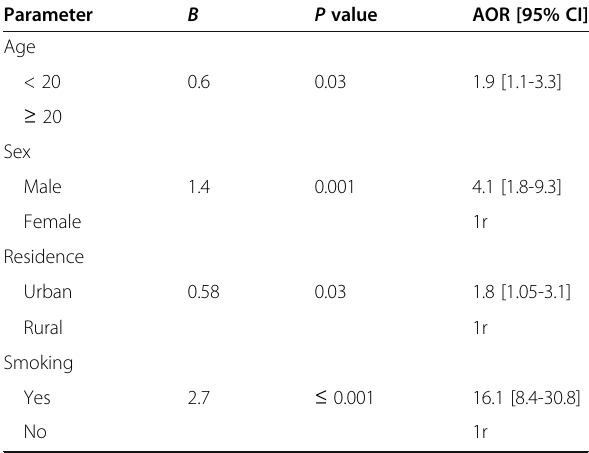
Table 5 Logistic regression of factors associated with substance